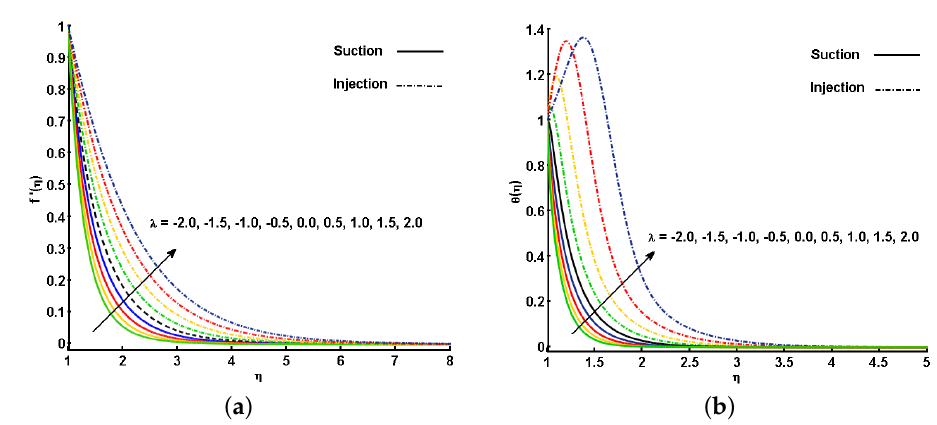
Figure 5. Effect of mass flux parameter ( λ ) on ( a ) velocity profile ( f (cid:48) ( η )) and ( b ) temperature profile ( θ ( η ) ).